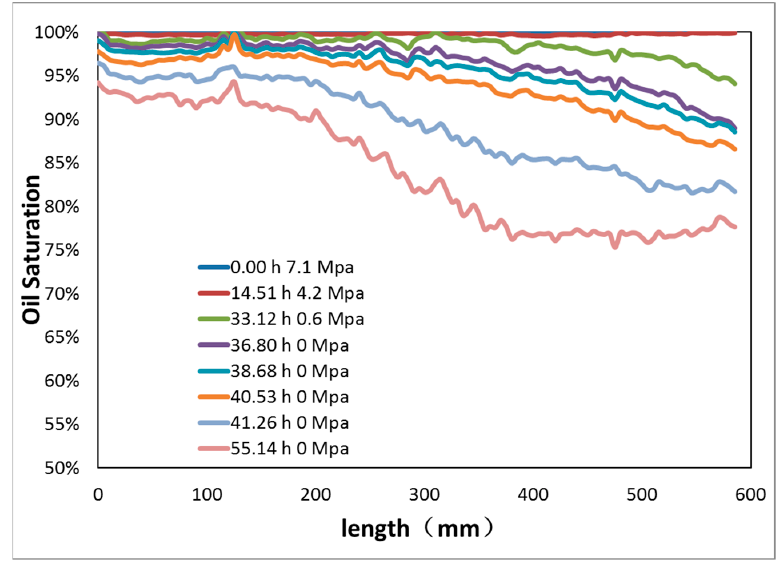
Figure 3. Oil saturation distribution curves in Experiment 2.